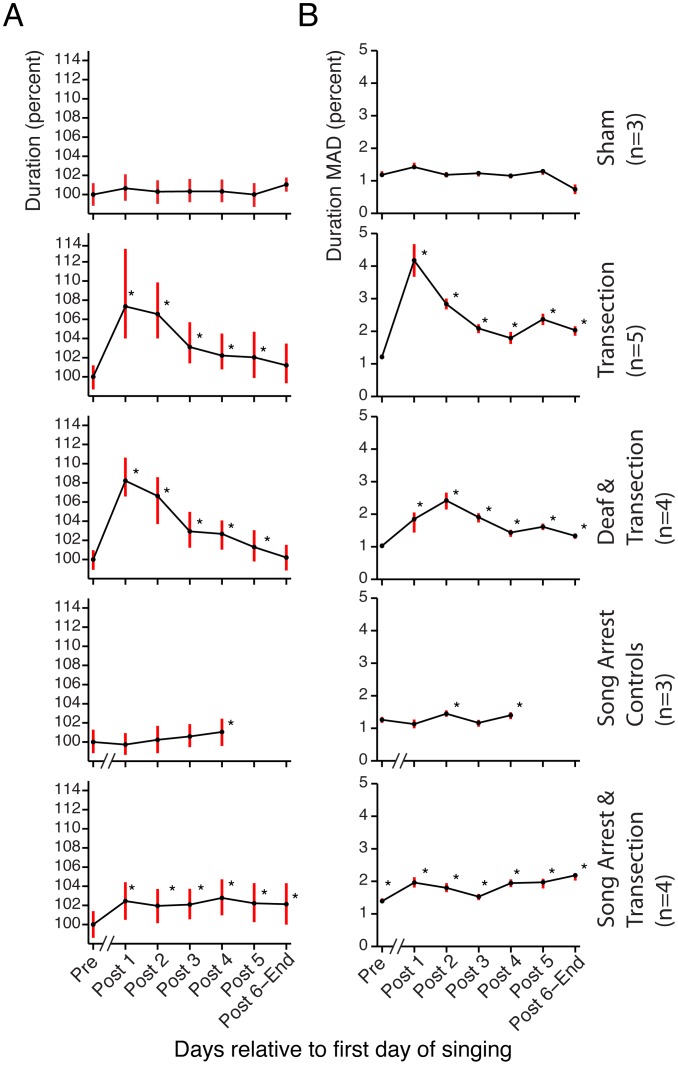
The effect of HVC transection on the duration of a single syllable mirrors the effect on syllable structure.(A) The median duration (given as a percentage of the median “Pre” duration) is plotted for each experimental group. Error bars indicate the first and third quartiles. The statistical tests follow those outlined in the legend for Figure 5. (B) The MAD of the duration is shown for each experimental group. This shows that the variance, in addition to median duration, increases transiently post-transection. Error bars indicate the 95% bootstrap confidence interval of the MAD. Here, * indicates p<.05 with Bonferroni correction, one-tailed Monte Carlo permutation test on the difference between MADs relative to the sham (10,000 randomizations for each test).